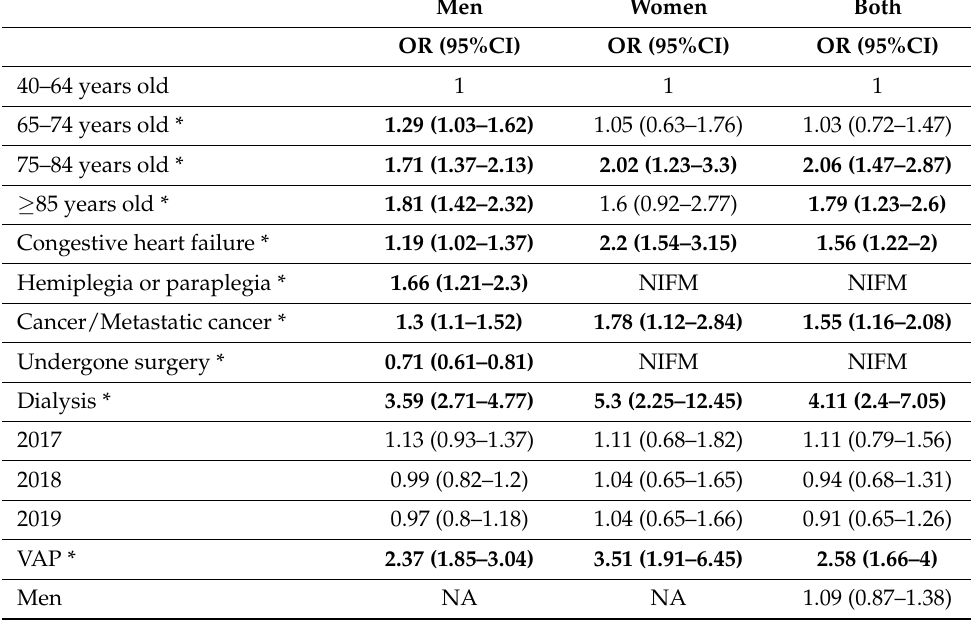
Table 5. Multivariable analysis of factors associated with in-hospital mortality during admissions for hospital-acquired pneumonia (HAP), among COPD patients according to sex. Men Women Both OR (95%CI) OR (95%CI) OR